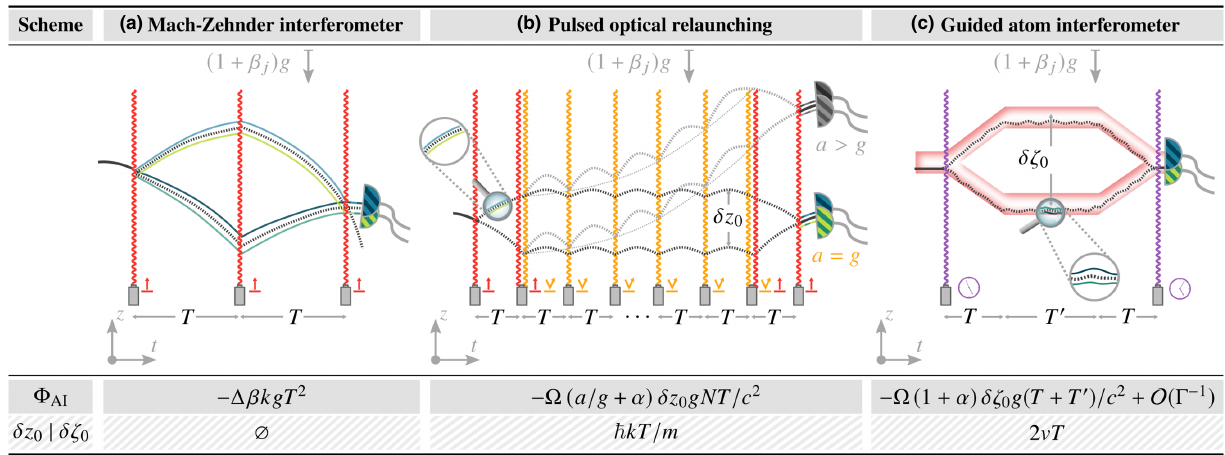
FIG. 2. Spacetime diagrams of different quantum-clock atom interferometers: a conventional Mach-Zehnder interferometer (a); a scheme relying on pulsed optical relaunching (b); and an interferometer guided by two trapping potentials to different heights, and back to the initial height (c). The center of each trap is bordered by red potential barriers, while the unperturbed trajectories z ( t ) of the atoms are represented by dashed black lines, highlighting the superposition between the arms of the interferometer. The diffracting Bragg pulses that act differently on each branch are denoted by red pulses. The yellow pulses are used for pulsed optical relaunching that is independent of the state and branch. One can measure the exit-port population for each internal state independently. To indicate this measurement scheme, we introduced two separate detectors colored in blue and green. Accordingly, the trajectories of each internal state caused by a perturbation through the dilaton field with an effective acceleration ( 1 + β j ) g are also drawn with these colors. The guided atom interferometer in panel (c) takes the same form as for two guided clocks with recoilless initialization and readout pulses, with the only difference that the atom is in a superposition of the branches (indicated by the dashed unperturbed trajectory). The differential phases (cid:12) AI are listed for each geometry in the table below. While the Mach-Zehnder interferometer in panel (a) is insensitive to the gravitational redshift, the pulsed optical relaunching in panel (b) mimics a UGR test for the special choice a = g , which corresponds to a vanishing effective acceleration and perfect levitation in the central segment. For other choices of a , the resulting effective acceleration leads on average to curved trajectories of the atoms, indicated by the grayed-out configuration. In this case one observes an accelerational redshift. The table also includes the respective height differences δ z 0 or δζ 0